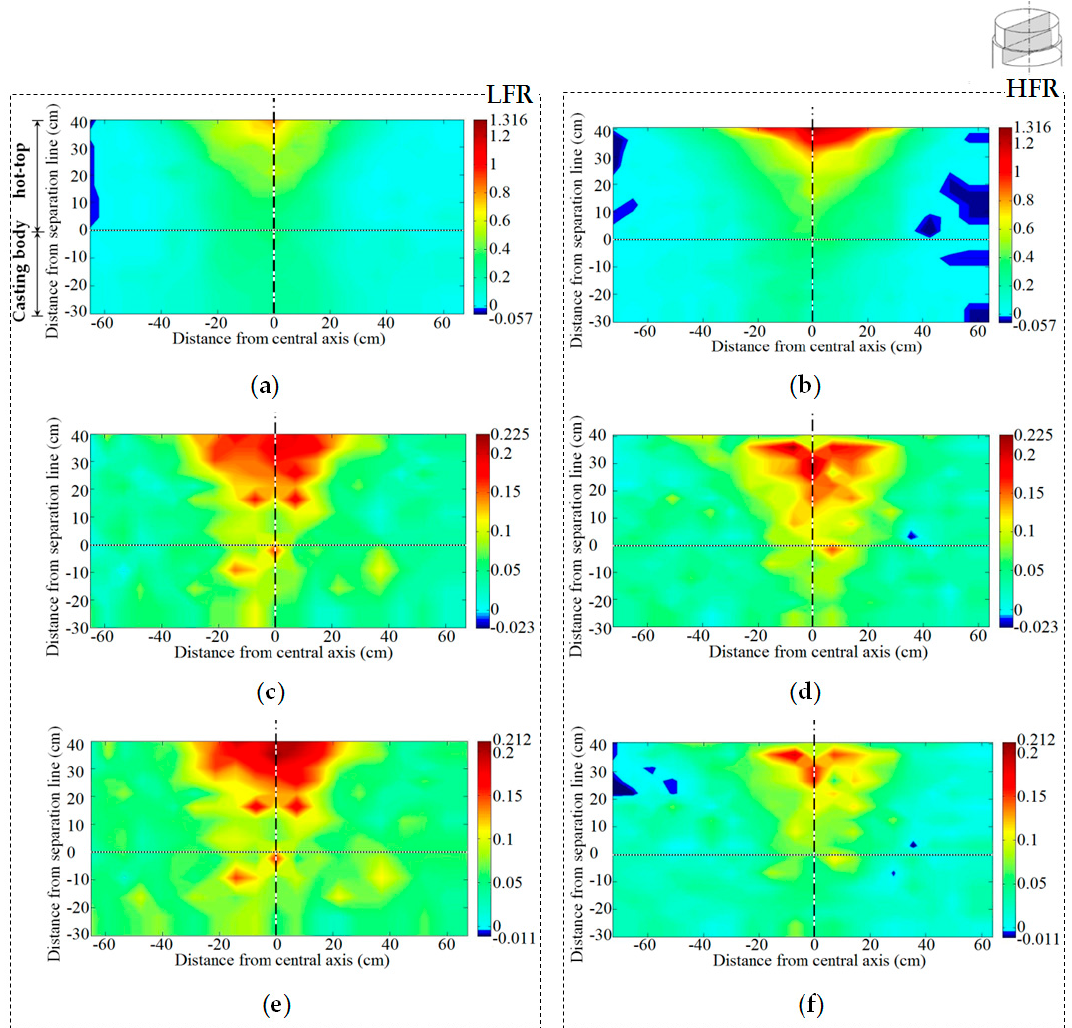
Figure 1. Segregation ratio patterns in the two ingots (LFR (Low Filling Rate ingot) and HFR (High Filling Rate ingot)) for the three analyzed solutes: ( a , b ) C; ( c , d ) Mn; ( e , f ) Cr.